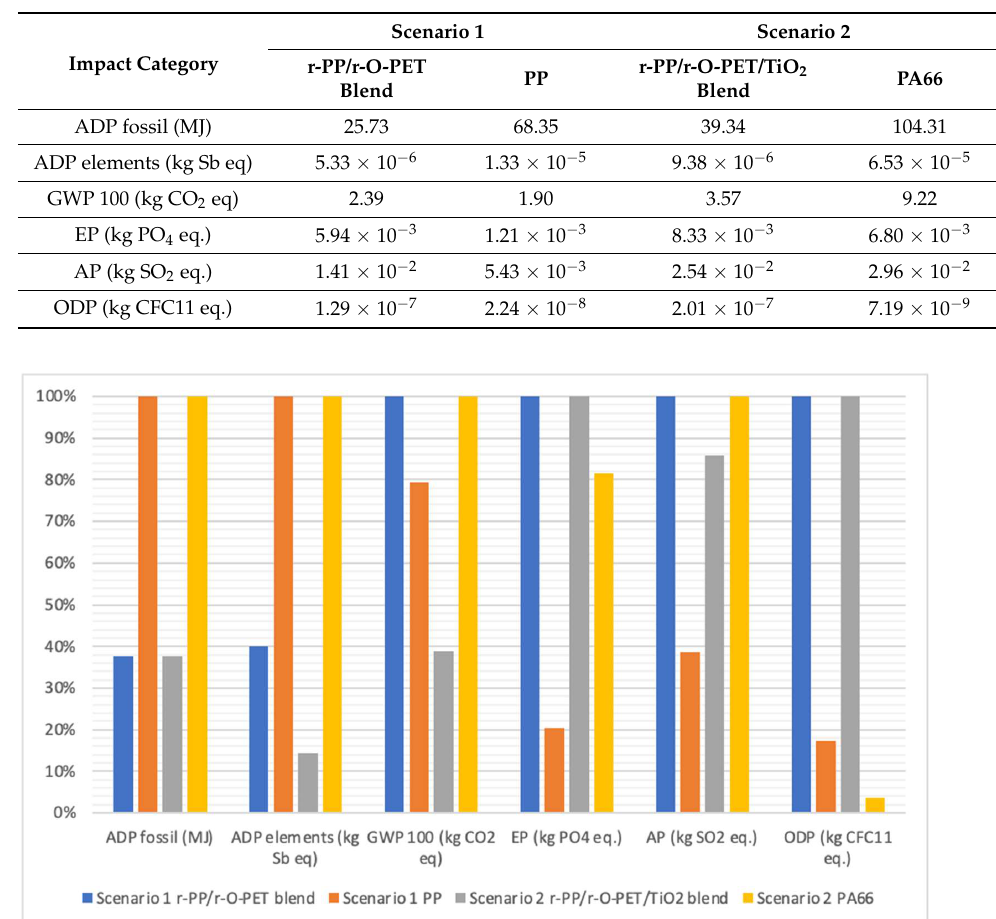
Table 6. Comparison between recycled blends and virgin polymers for Scenario 1 and Scenario 2.